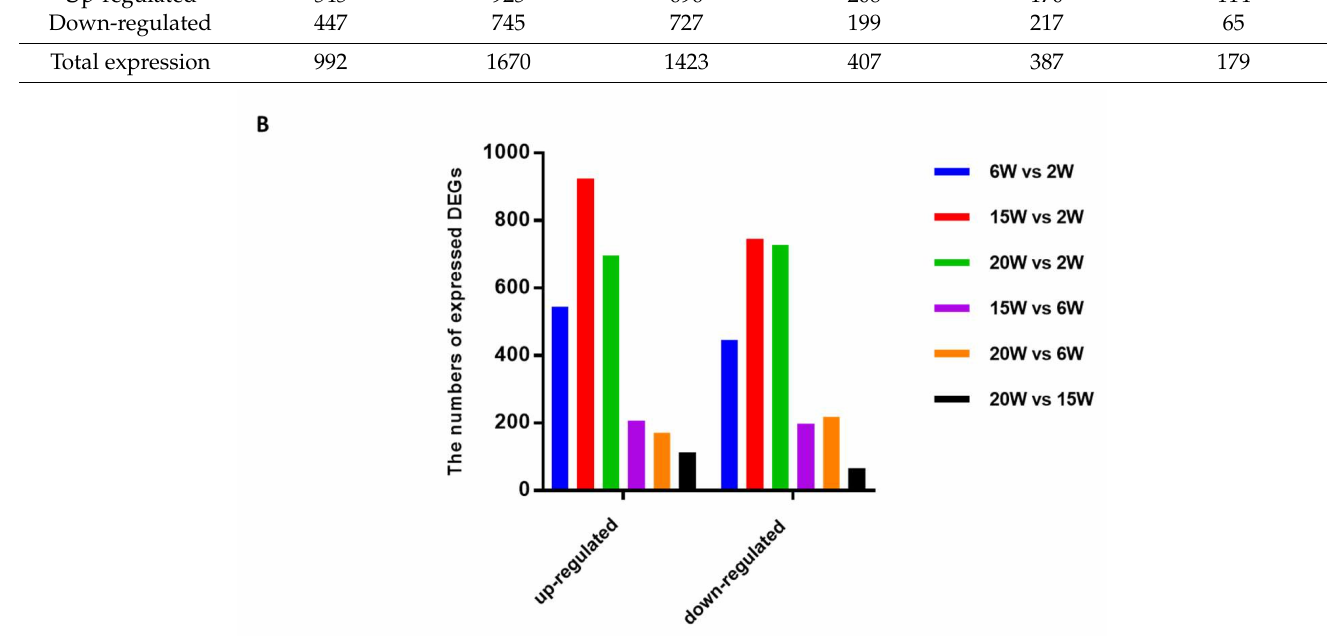
Figure 1. Experimental scheme of this study. Table 2. Numbers of differentially expressed genes (DEGs) based on comparisons between the reproductive stages of the mouse ovary. ( A ) Total expression and upregulated and downregulated DEG numbers based on comparison for each aged mouse ovaries. ( B ) Quantitative graph of up- and downregulated DEG numbers. A 6 W vs. 2